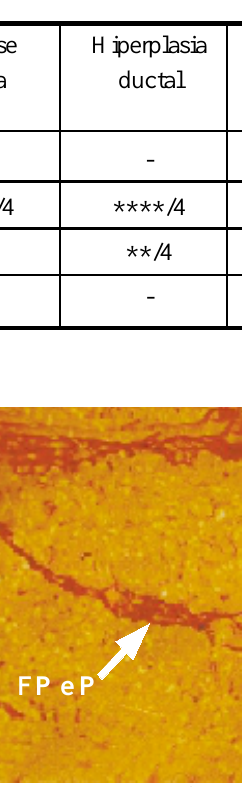
FIGURA 8 - Fotografia apresentando o preparado histológico do grupo 1 (controle) com coloração Picrosírius, 100x.